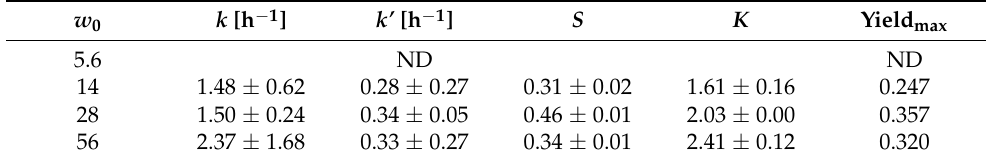
Table 2. Effect of w 0 on dipeptide synthesis (pH = 5, DCC = 7 mol/m 3 ).